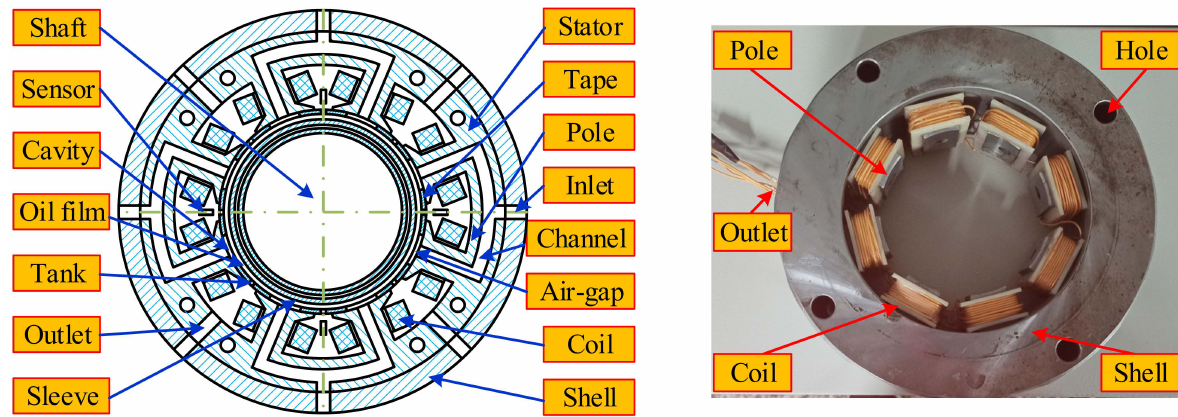
Figure 2. Structure of radial unit of